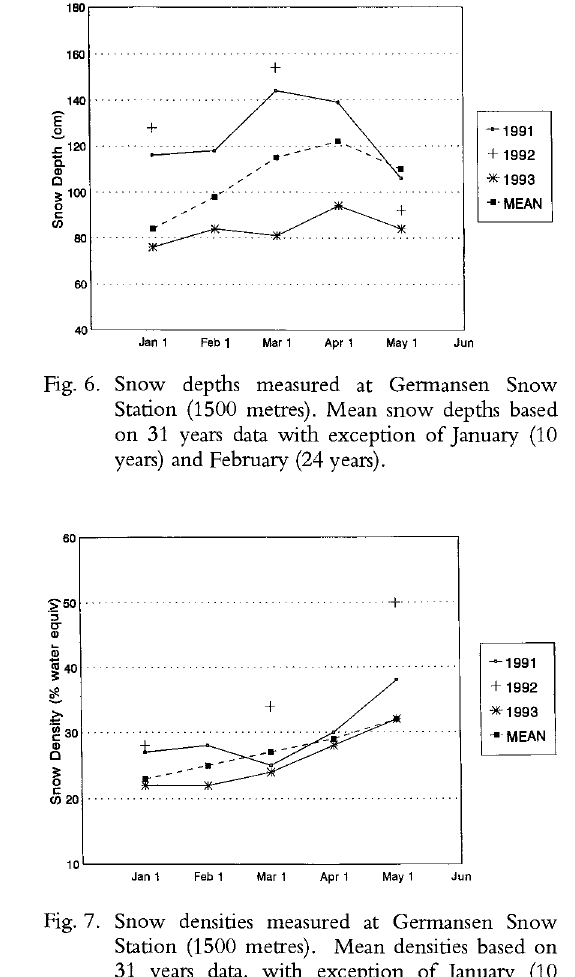
Fig. 7. Snow densities measured at Germansen Snow Station (1500 metres). Mean densities based on 31 years data, with exception of January (10 years) and February (24 years).